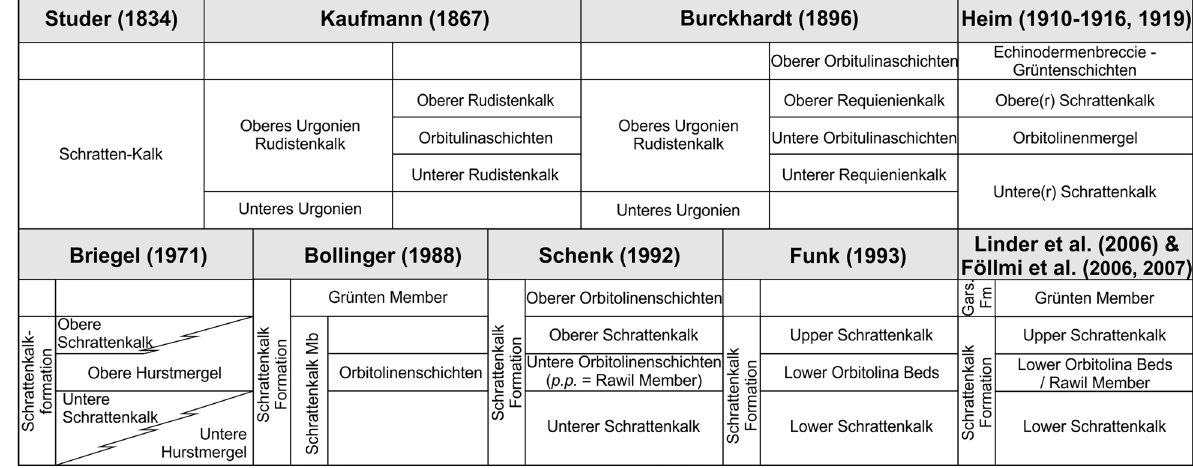
Fig. 2 Summary table of the various historical terminologies used for the Schrattenkalk Formation and